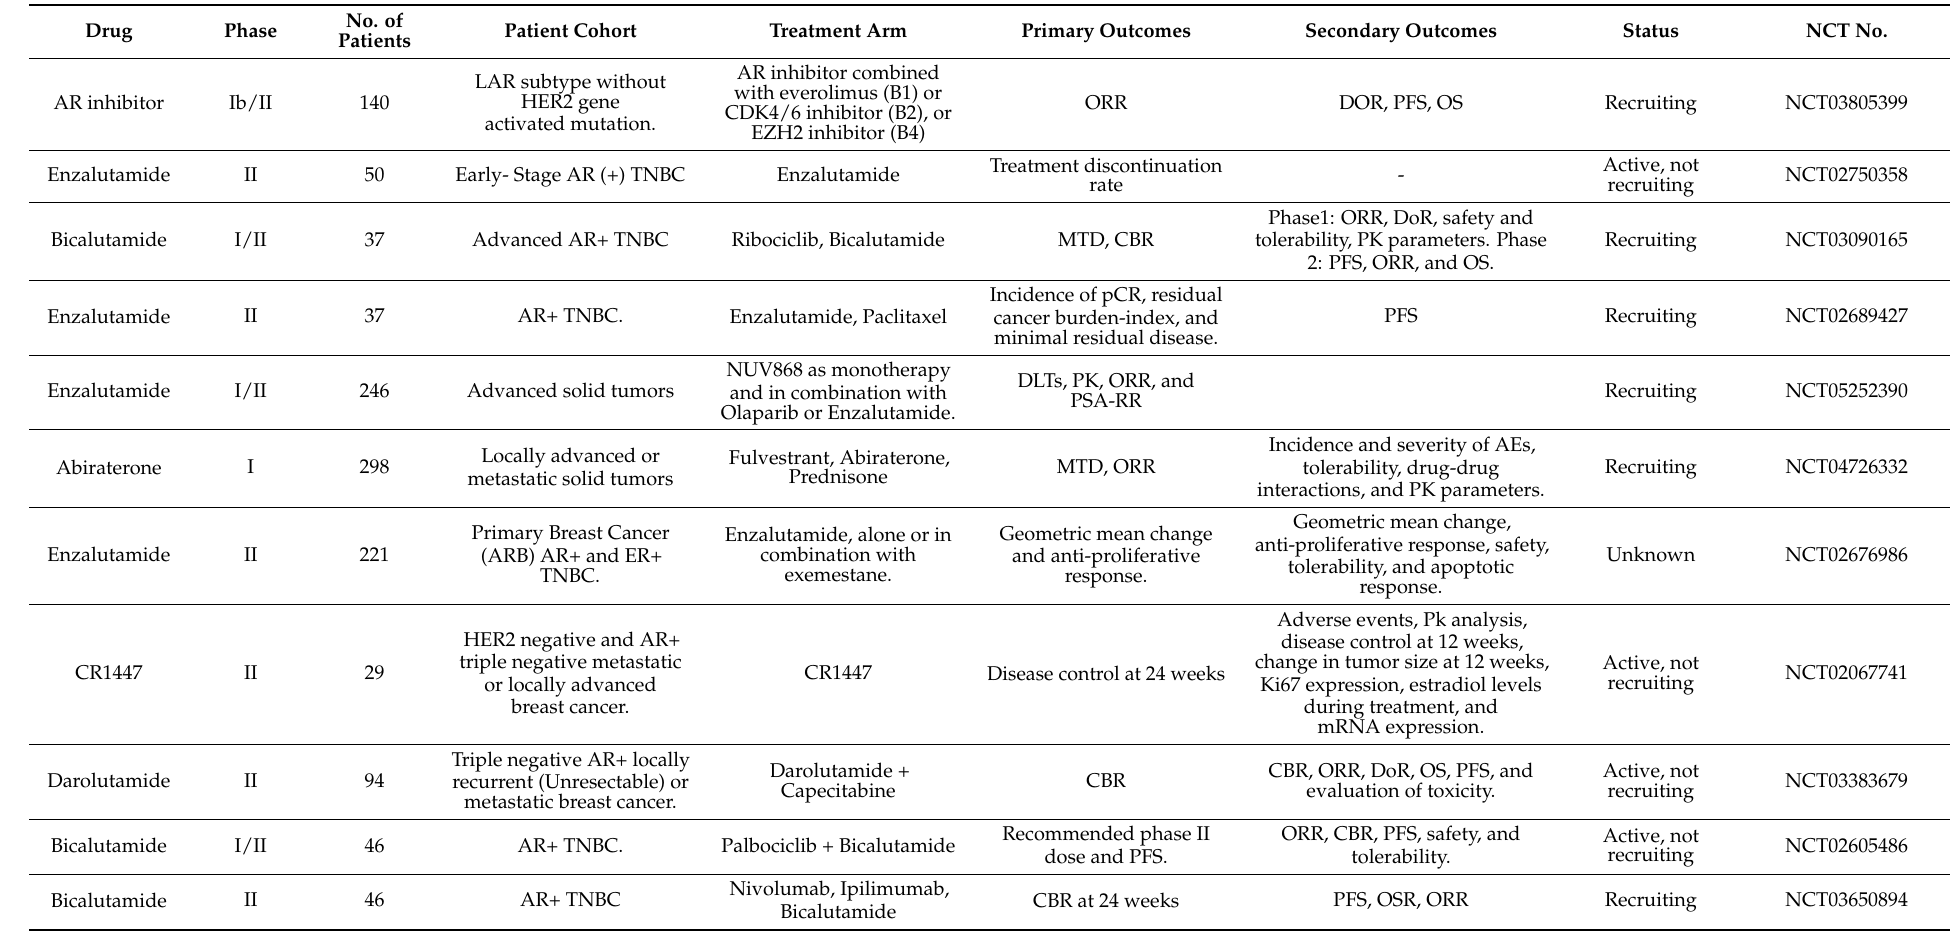
Table 2. List of ongoing trials aiming to evaluate the clinical profile of anti-androgenic